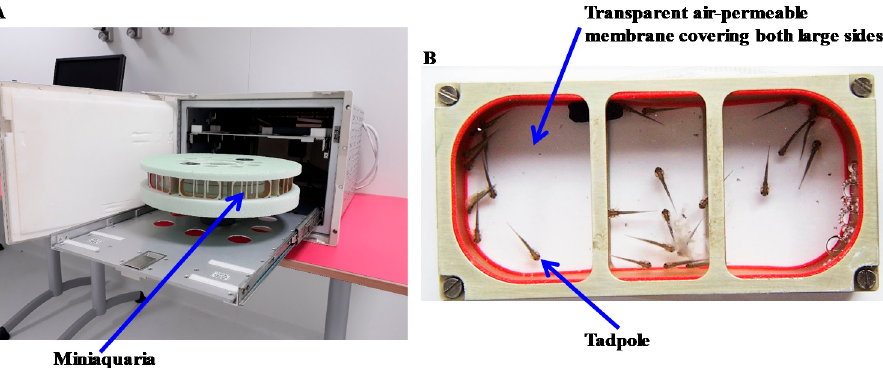
Figure 4. ( A ) Rotor allowing the centrifugation of 10 miniaquariums without a food supply and a water cleaning system. ( B ) Each miniaquarium is 80 mm long, 40 mm wide, and 20 mm high and has two transparent faces that are permeable to O 2 and CO 2 but impermeable to H 2 O. In ( B ), amphibian tadpoles can be seen.